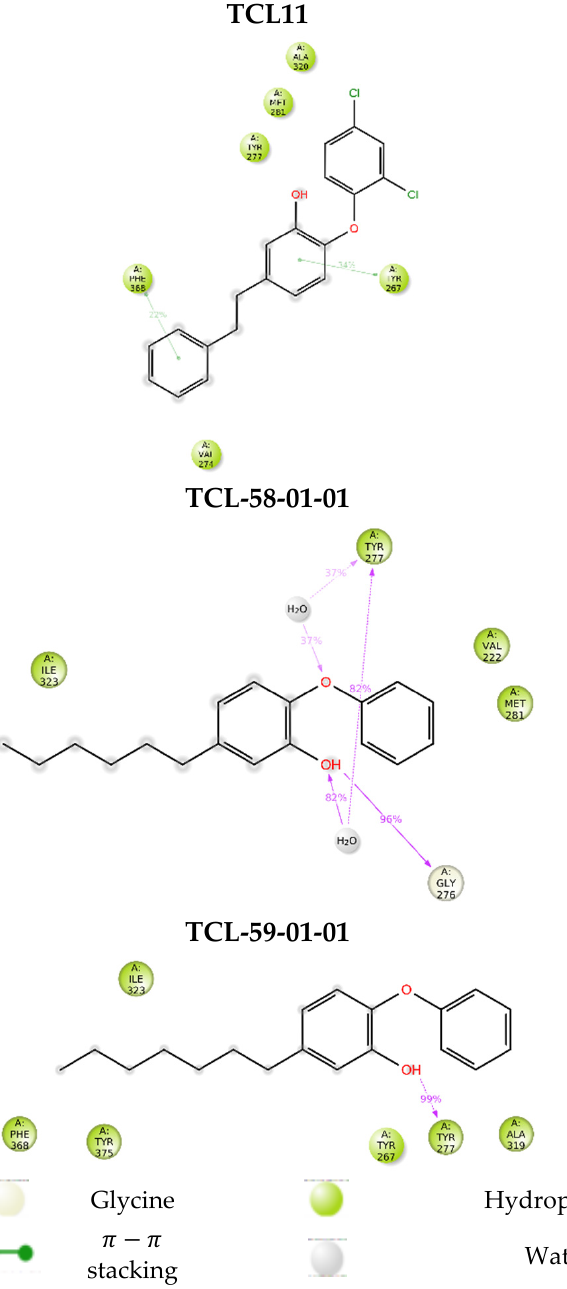
Figure 12. 2D representation of the most populated attractive interactions between the function groups of the six inhibitors and the individual residues at the active site of Pf ENR that occur in at least in 1/5 of the 500 analysed frames.